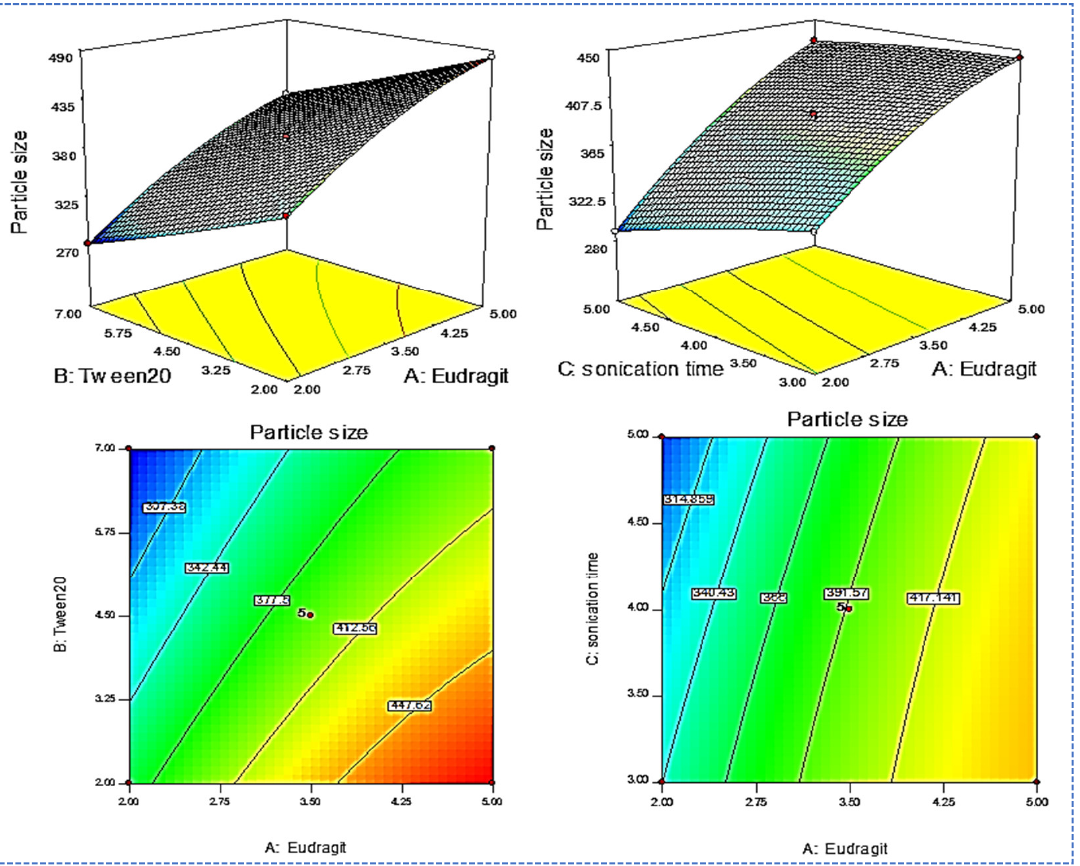
Figure 1. Response surface plot showing effect of Eudragit RSPO (A), Tween 20 (B), and sonication time (C) on the hydrodynamic diameter (Y 1 ).